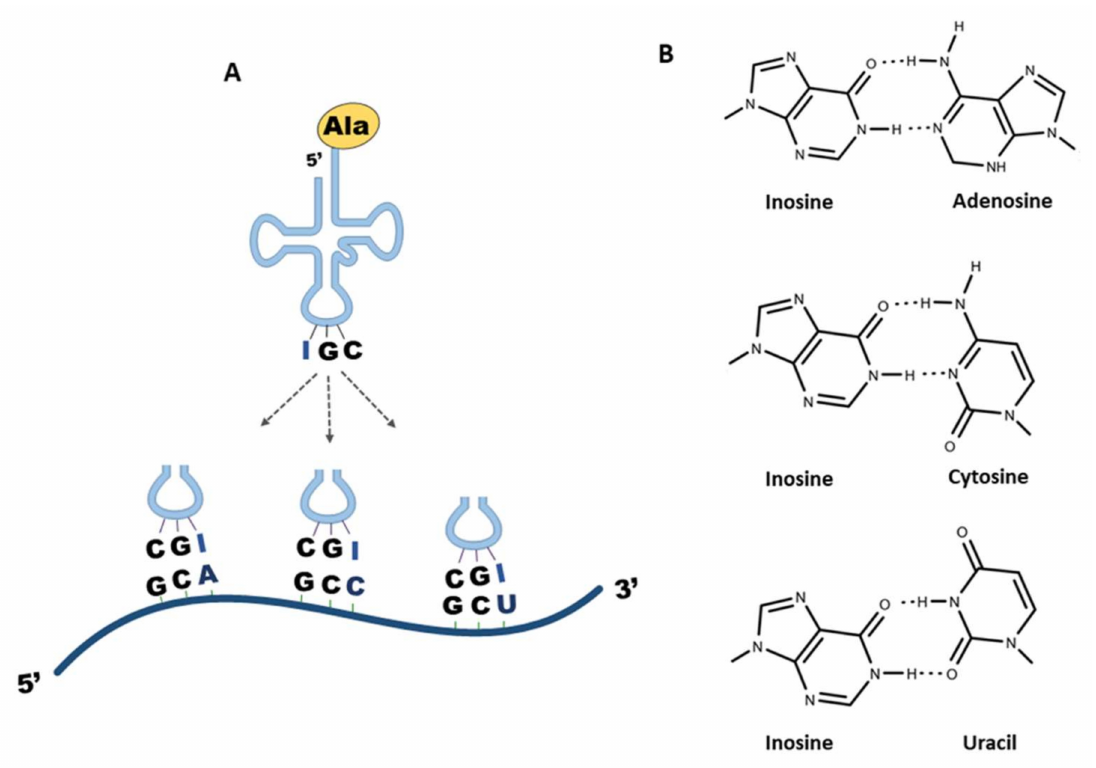
Figure 3. Inosine base pairing. ( A ) Inosine modified tRNA Ala with the anticodon IGC base-pairs with its synonymous codons GCA, GCC, and GCU. ( B ) Hydrogen bonding of inosine with adenosine, cytosine, and